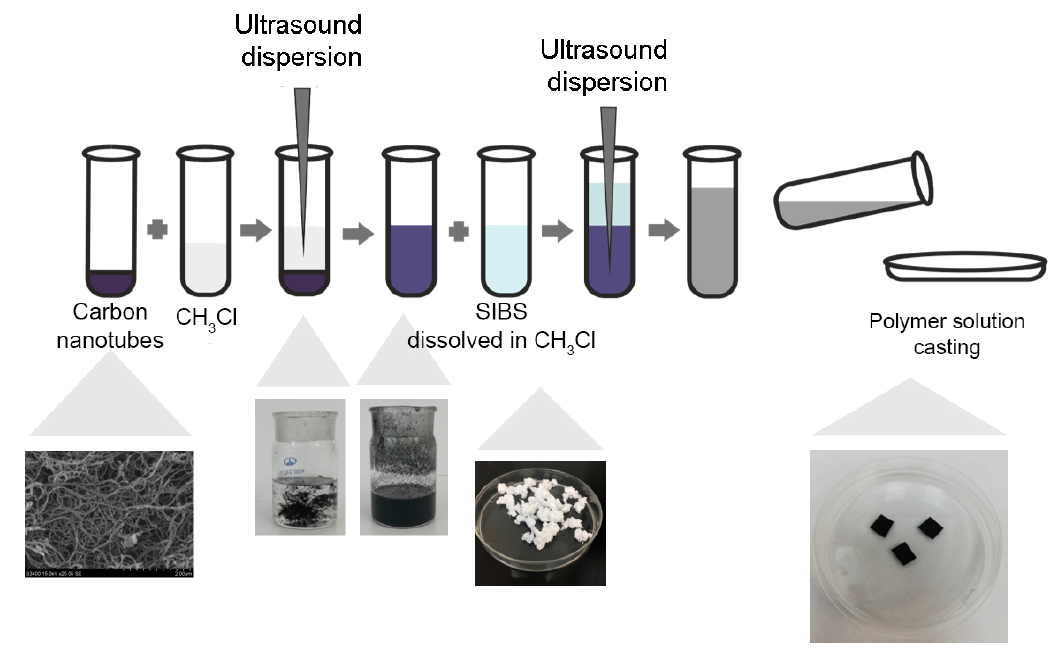
Figure 1. Study pipeline illustrating the fabrication of nanocomposite films based on carbon nanotubes incorporated into poly(styrene- block -isobutylene- block -styrene) (SIBS).